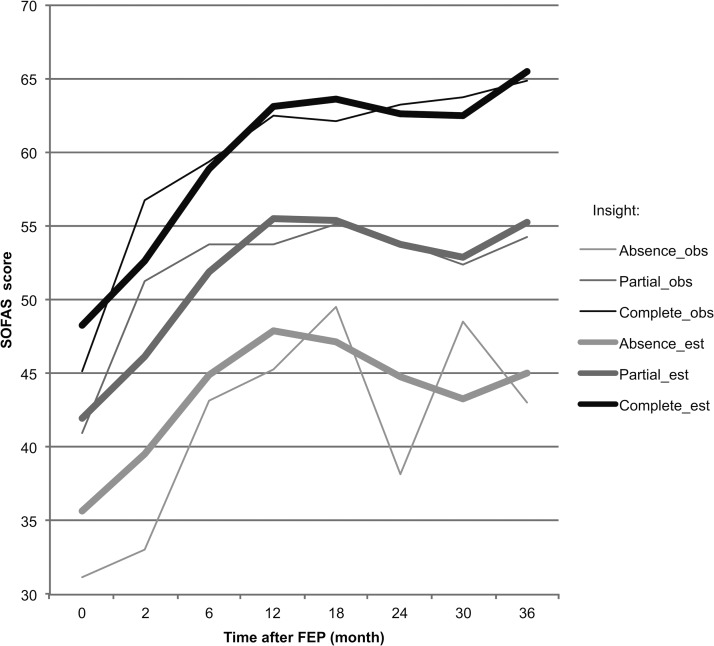
Evolution of estimated and observed SOFAS scores according to level of insight during the treatment. Insight: obs, SOFAS observed score; est, SOFAS estimated score (multilevel analysis).